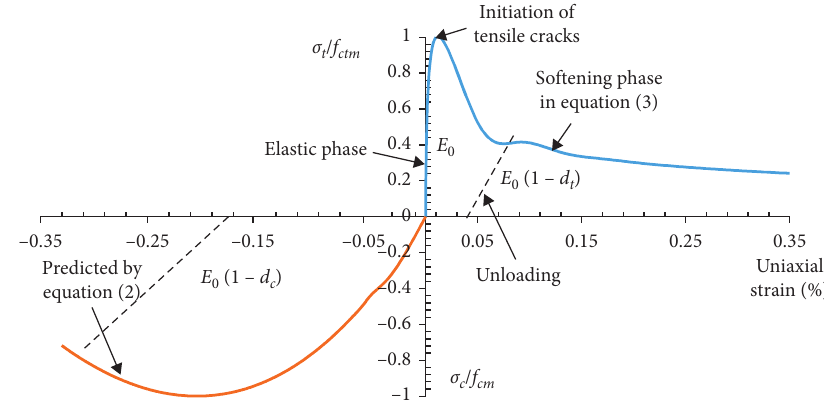
Figure 2: Nondimensionalized stress-strain curves of concrete uniaxial behavior introduced in the FE Table 1: Parameters used for CDP model in Abaqus. Dilation angle K c